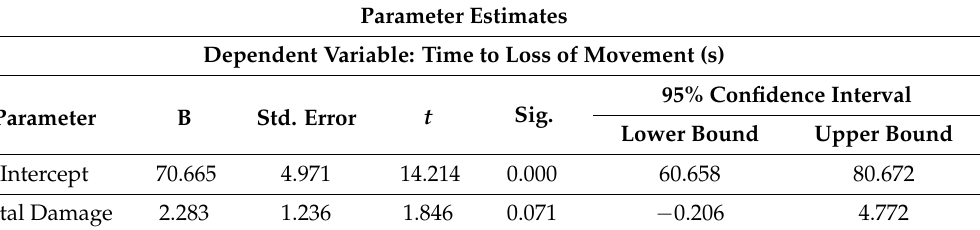
Table 4. Parameter estimates from the GLM testing for an effect of total damage score on time to loss of movement (s).